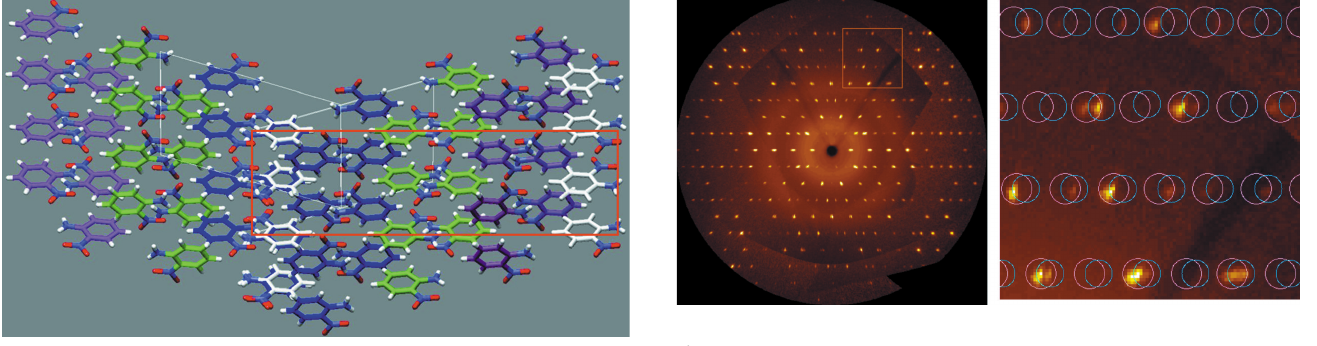
Figure 3 Twin domains viewed down the monoclinic b -axis, with alternate layers colored in white, blue, green and magenta. The layers have a width of two hydrogen-bonded molecules (see Fig. 2) and have hydrophobic faces. The second lattice (left) has a row of molecules in the blue layer in common with that of the white layer in the first lattice (right). The second domain is generated by a twofold rotation around c and a shift over 1 /2 a . The pseudo-orthorhombic unit cell is shown in red. The hydrophobic inter- actions between the layers are almost completely conserved across the twin interface.